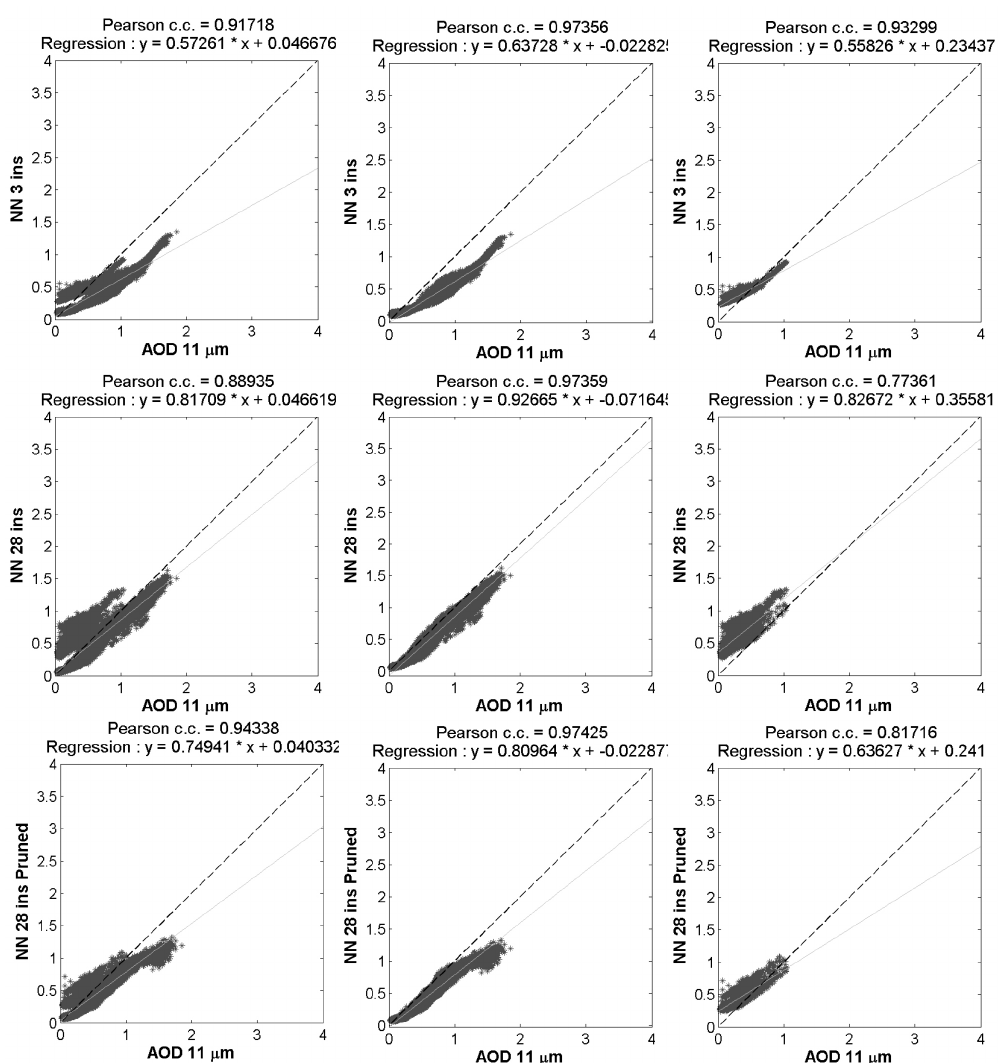
Figure 11. Scatterplots for AOD networks, 3 inputs (top row), 28 inputs (middle row) and 28 inputs pruned (bottom row), applied to the validation set of 11 May 2010, 14:05UTC, divided into total patterns (left column), patterns over sea (middle column) and patterns over meteorological clouds (right